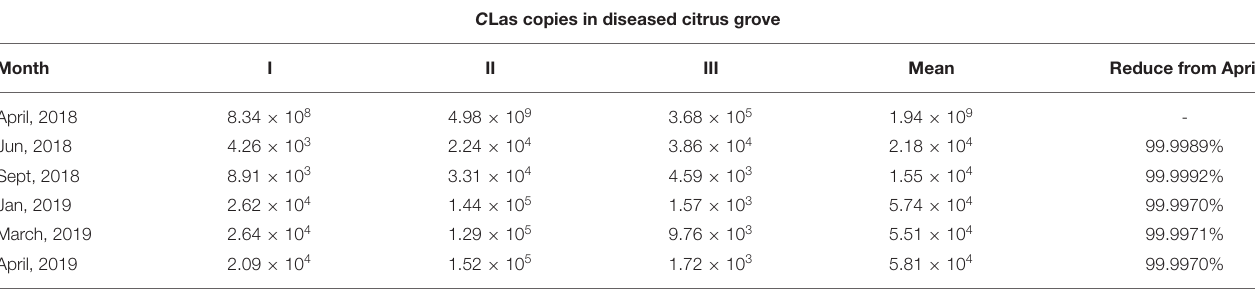
TABLE 1 | Reduction of Candidatus Liberibacter asiaticus ( C Las) pathogen copies during different time intervals 2018–2019. C Las copies in diseased citrus